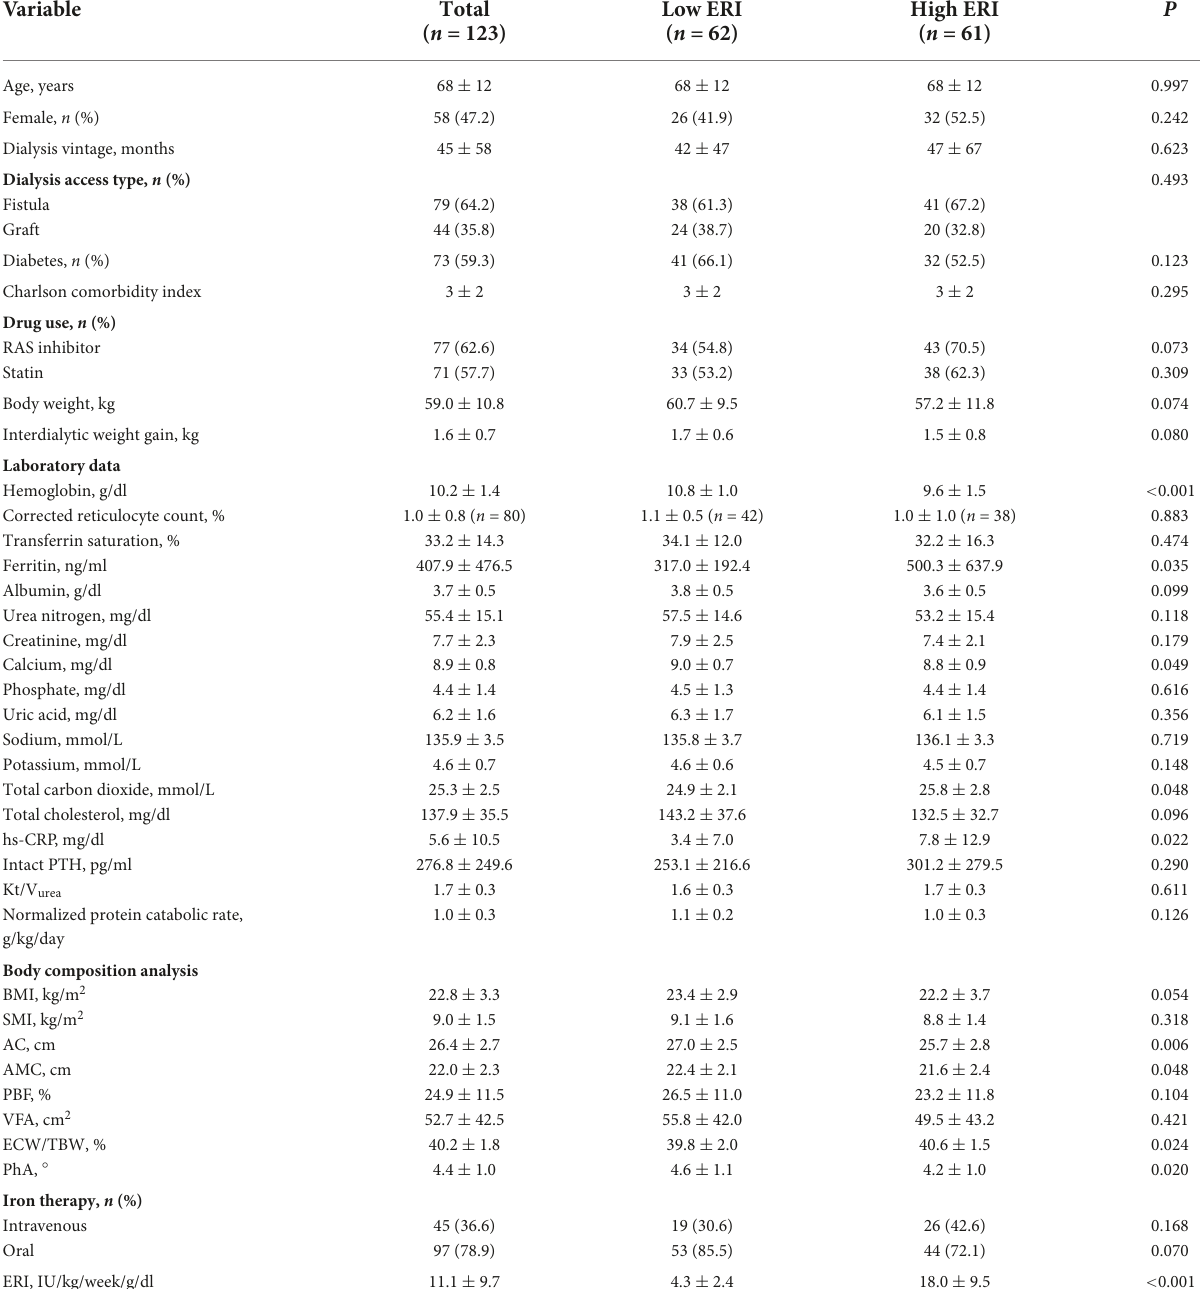
TABLE 1 Characteristics of patients according to